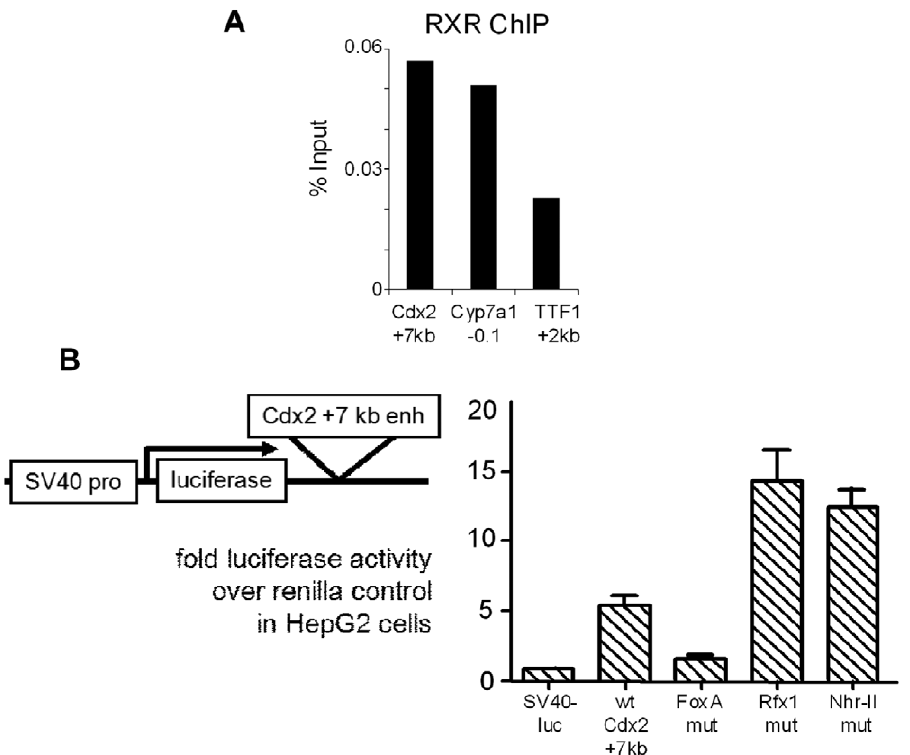
Figure 7. Repressive NHR-II factor binding to the Cdx2 + 7 kb enhancer. (A) ChIP for RXR in HepG2 cells showing occupancy at the Cdx2 + 7 kb enhancer comparable to that at the positive control site at the Cyp7a1 promoter, versus the signal at the negative control TTF1 + 2 kb enhancer. (B) Dual-reporter luciferase assays using the Cdx2 element, with combinations of FoxA, Rfx1, and NHR-II site mutations. Cells were co-transfected with pRL-CMV-renilla and the indicated pGL3 reporter plasmids. Luciferase activity expressed as fold over the empty pGL3 vector after normalization to CMV-renilla in arbitrary units. The overall transfection efficiency of this experiment was lower than that seen in Figure 4.